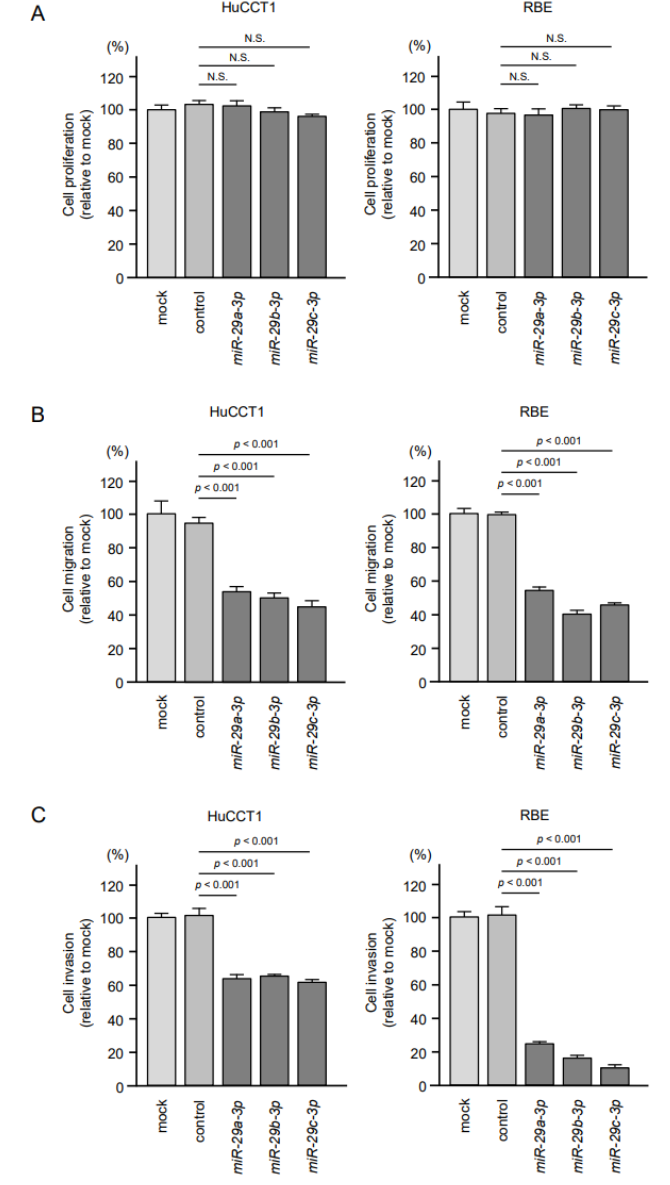
Figure 2. Effects of miR-29a-3p , miR-29b-3p and miR-29c-3p on functions (cell proliferation, migra- tion and invasion) of intrahepatic cholangiocarcinoma (ICC) cell lines (HuCCT1 and RBE). ( A ) Cell proliferation was assessed using XTT assays. Data were collected 72 h after miicroRNA transfec- tion. Ectopic expression of miR-29a-3p , miR-29b-3p and miR-29c-3p did not affect cell proliferation. ( B , C ) Cell migration and invasive abilities were significantly blocked by ectopic expression of miR- 29a-3p , miR-29b-3p and miR-29c-3p in ICC cells. Error bars represent mean ± standard error (SE).